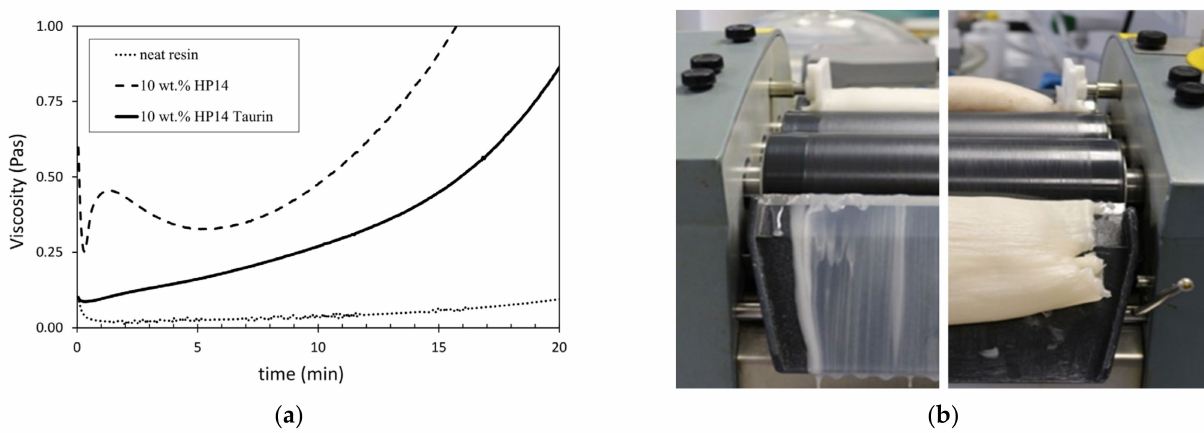
Figure 5. ( a ) Viscosity over time of the neat resin and the nanocomposites with 10 wt.% HP14 and HP14 taurine analysed by a plate-plate rheometer at 70 ◦ C; ( b ) Flow behaviour of the masterbatch during dispersion by a three-roll mill: epoxy resin with 30 wt.% HP14 taurine ( left ), epoxy resin with 30 wt.% HP14 ( right